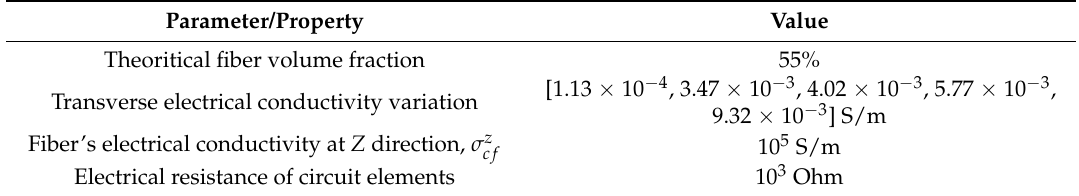
Table 3. Input parameters and materials properties in the macro-scale model.